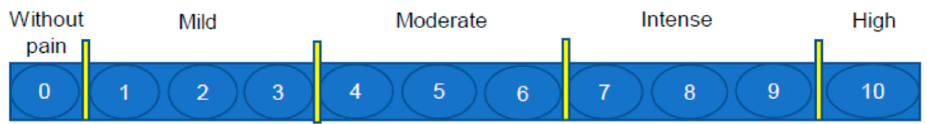
Figure 1. Visual analog scale used to evaluate pain level.